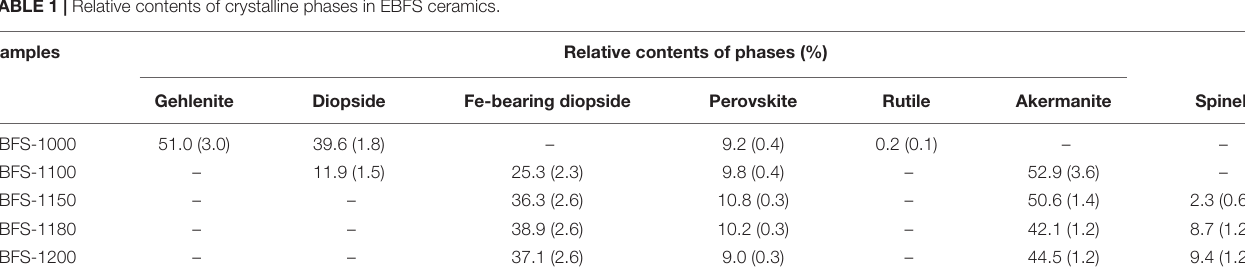
FIGURE 1 | X-ray powder diffraction patterns of EBFS ceramics at different sintering temperatures: (A) 1,000 and 1,100 ◦ C, (B) 1,150, 1,180, and 1,200 ◦ C (Ak, Akermanite; D, Diopside; P, Perovskite; G, Gehlenite; R, Rutile; DFe, Fe-bearing Diopside; Sp, Spinel). TABLE 1 | Relative contents of crystalline phases in EBFS ceramics.